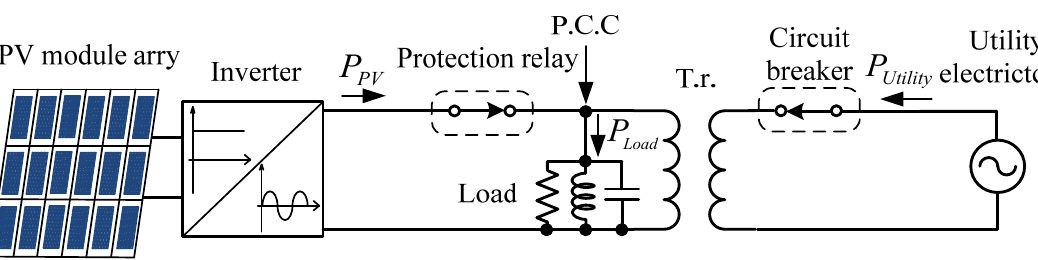
Figure 1. Photovoltaic and utility grids connected in